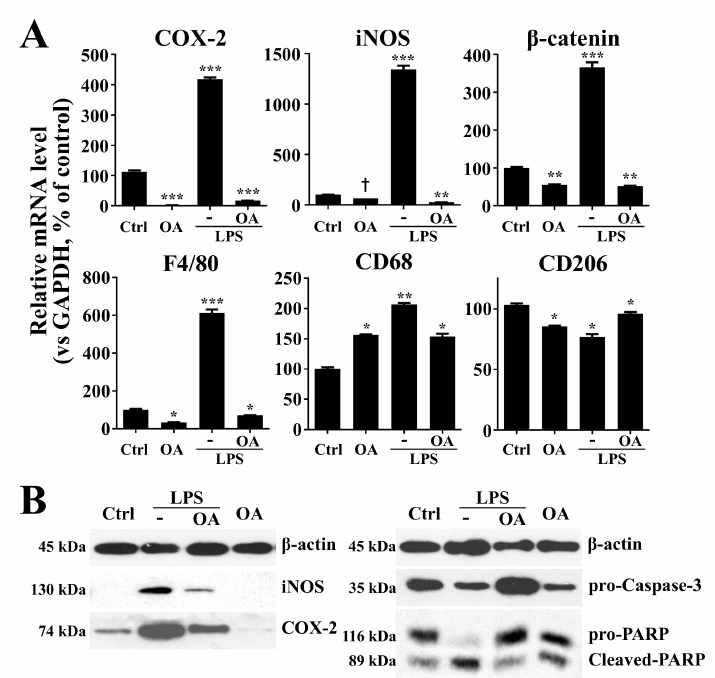
Figure 3. OA treatment alleviates the expression of various factors in the mRNA and/or protein levels. (A) qPCR revealed that OA treatment reduced the expression of inflammatory related factors elevated by LPS. *, **, and *** represent significant different from the control with a p < 0.05, 0.01 and 0.001, respectively. † represented no significant difference comparing with the control. (B) Western blot analysis on the expression levels of various proteins. The molecular weight of each protein was indicated at the left side of the